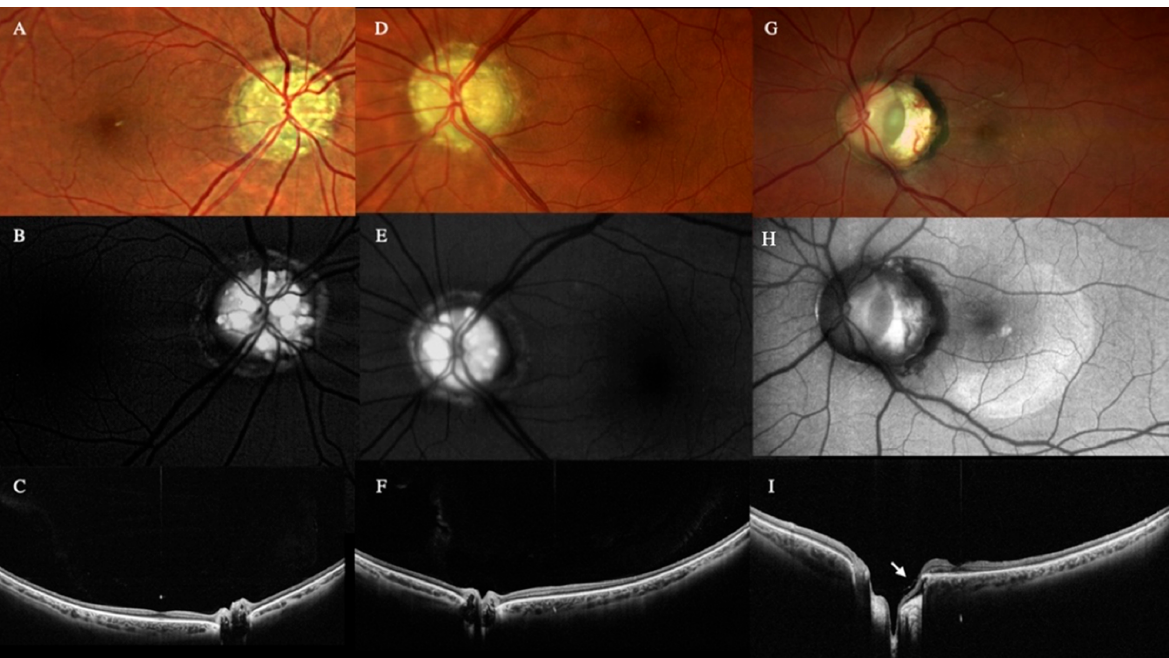
Figure 5. Optic nerve color photo ( A , D ) and autofluorescence ( B , E ) of a patient with bilateral optic nerve drusen (OND). Notice the hyper-autofluorescence in both optic nerves. Wide-field (WF) and deep field (DF) optical coherence tomography (OCT) radial scan centered on the optic nerve ( C , F ) of the right and left eye. OCT shows the OND as oval hyporeflective lesions with hyperreflective borders. Optic nerve retinography ( G ) and autofluorescence ( H ) of a temporal optic nerve coloboma. WF-OCT image ( I ) shows the herniation of the retina into the colobomatous area. This patient underwent a vitrectomy and internal limiting membrane (ILM) flap to treat the retinal detachment. Notice the ILM flap (arrow) and the absence of retinal detachment five years after the surgery.